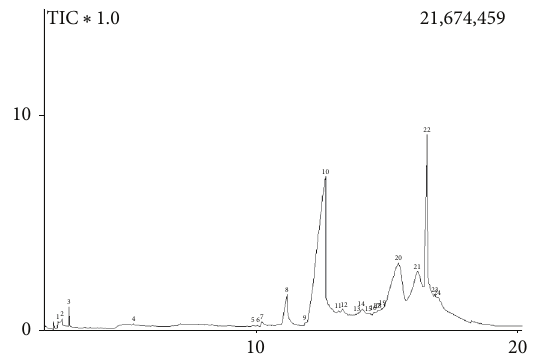
Figure 2: Total ion chromatogram obtained in the analyses of cachac¸a sample from Minas Gerais through GC-MS. The numbers corresponding to the following compounds. 1: formic acid. 2: acetic acid. 3: hydroxy 2-propanone. 8: furfural, 10: 4-methyl-4-hepten-3- one. 20: 2-hydroxyethylcarbamate, 22: 5-hydroxymethyl furfural (5-